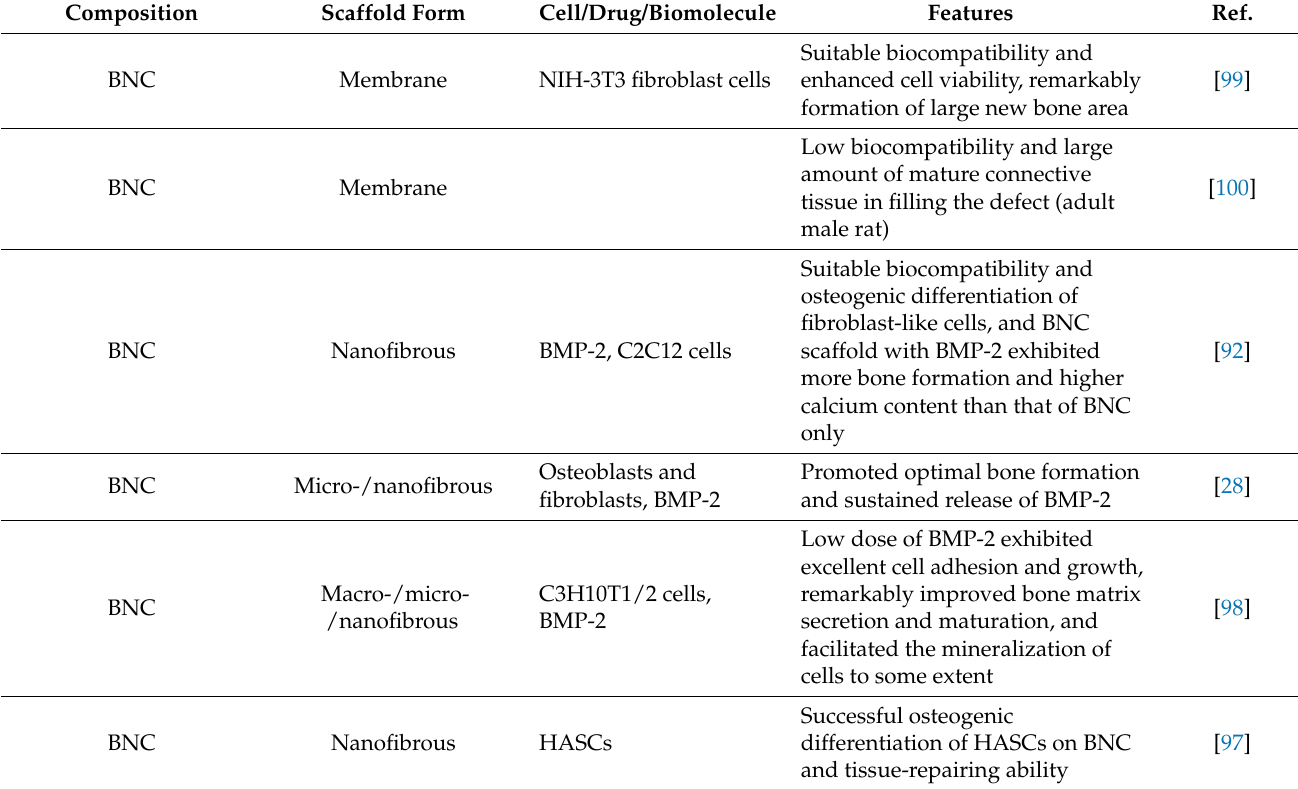
Table 1. Potential BNC-based biomaterials for dental and bone tissue regeneration. Composition Scaffold Form Cell/Drug/Biomolecule Features